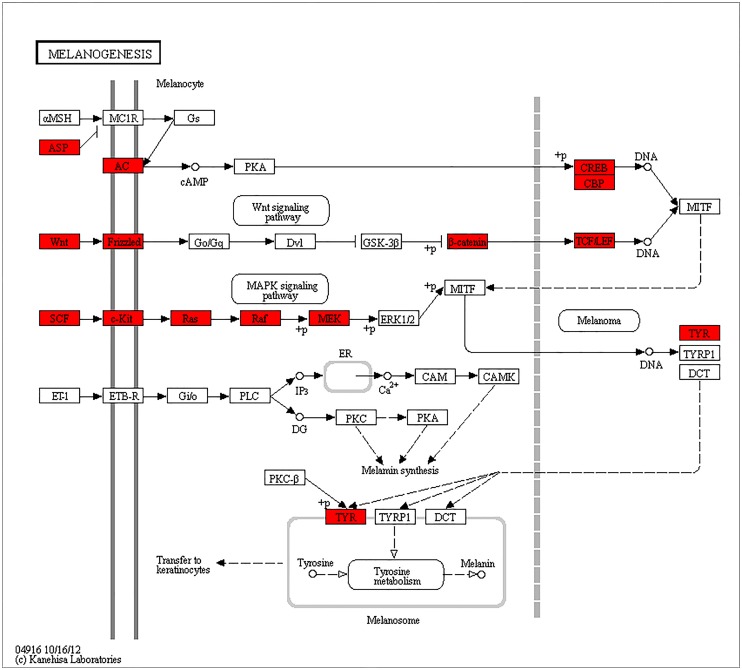
The differentially expressed skin color genes identified in the analyzed chicken skin and their involvement in the melanogenesis pathway.The genes with a red frame are upregulated in the black skin compared to the white skin.